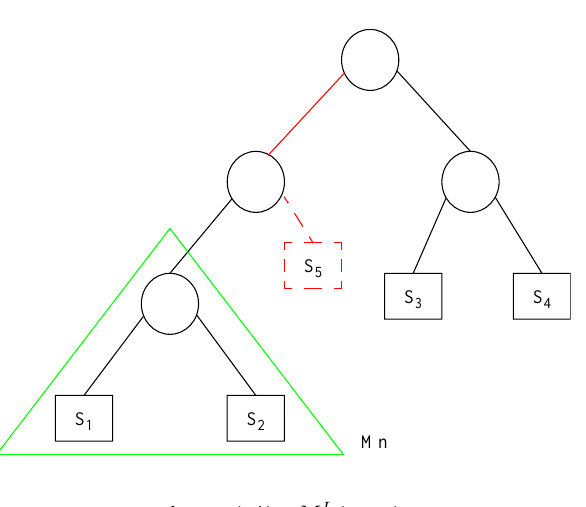
Fig. 1: Finding M I n in a